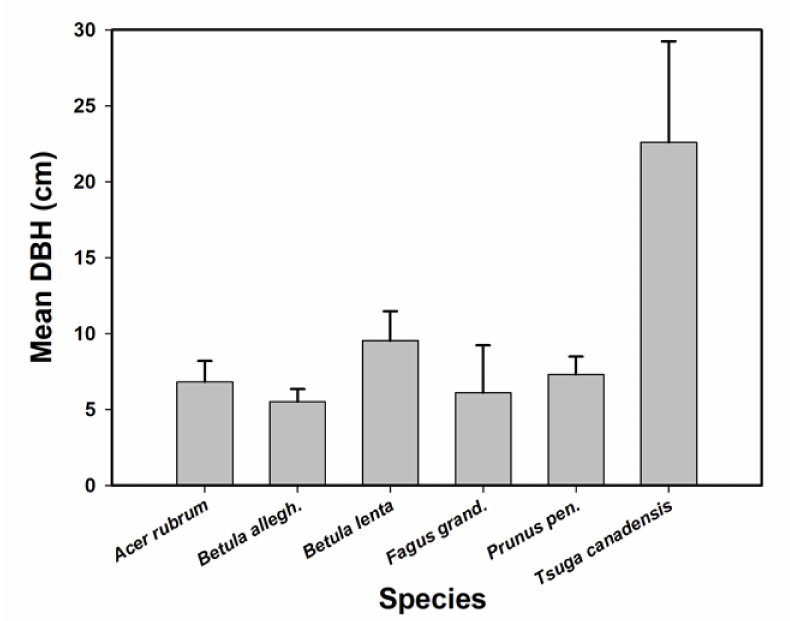
Figure 3. Mean and standard deviation of diameter at breast height (dbh, in cm) for stems in recovering stand, ten years after